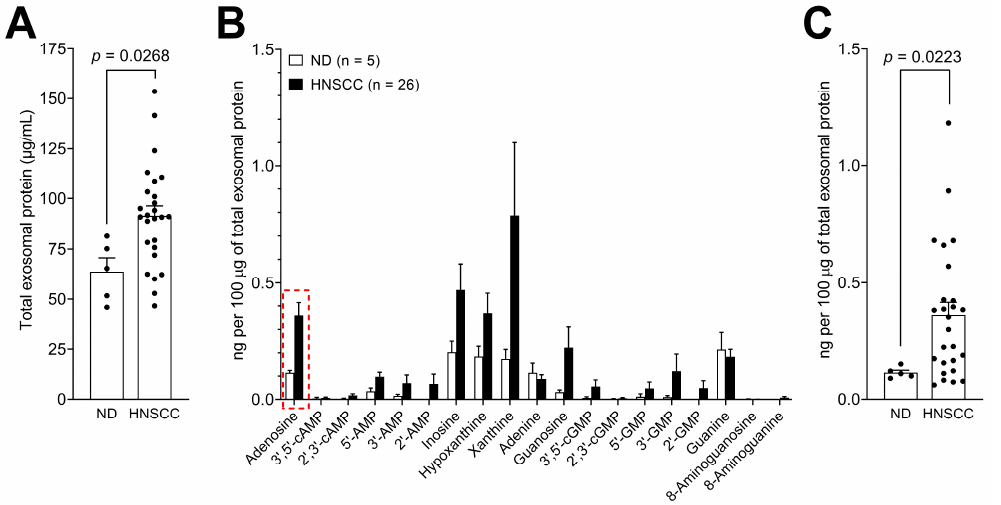
Figure 4. Purine metabolites are enriched in exosomes isolated from the plasma of HNSCC patients compared to those isolated from normal donors (ND). ( A ) Total exosomal protein levels (µg/mL) in samples isolated from the plasma of patients with HNSCC or ND. ( B ) Comparison of purine metabolite levels in exosomes isolated from the plasma samples of HNSCC patients or ND. Values are presented in ng normalized to 100 µg of total exosomal protein. ( C ) Individual values of adenosine levels in exosomes isolated from HNSCC or ND. Values correspond with the data marked with the red frame presented in (B). All values represent means ± SEM.